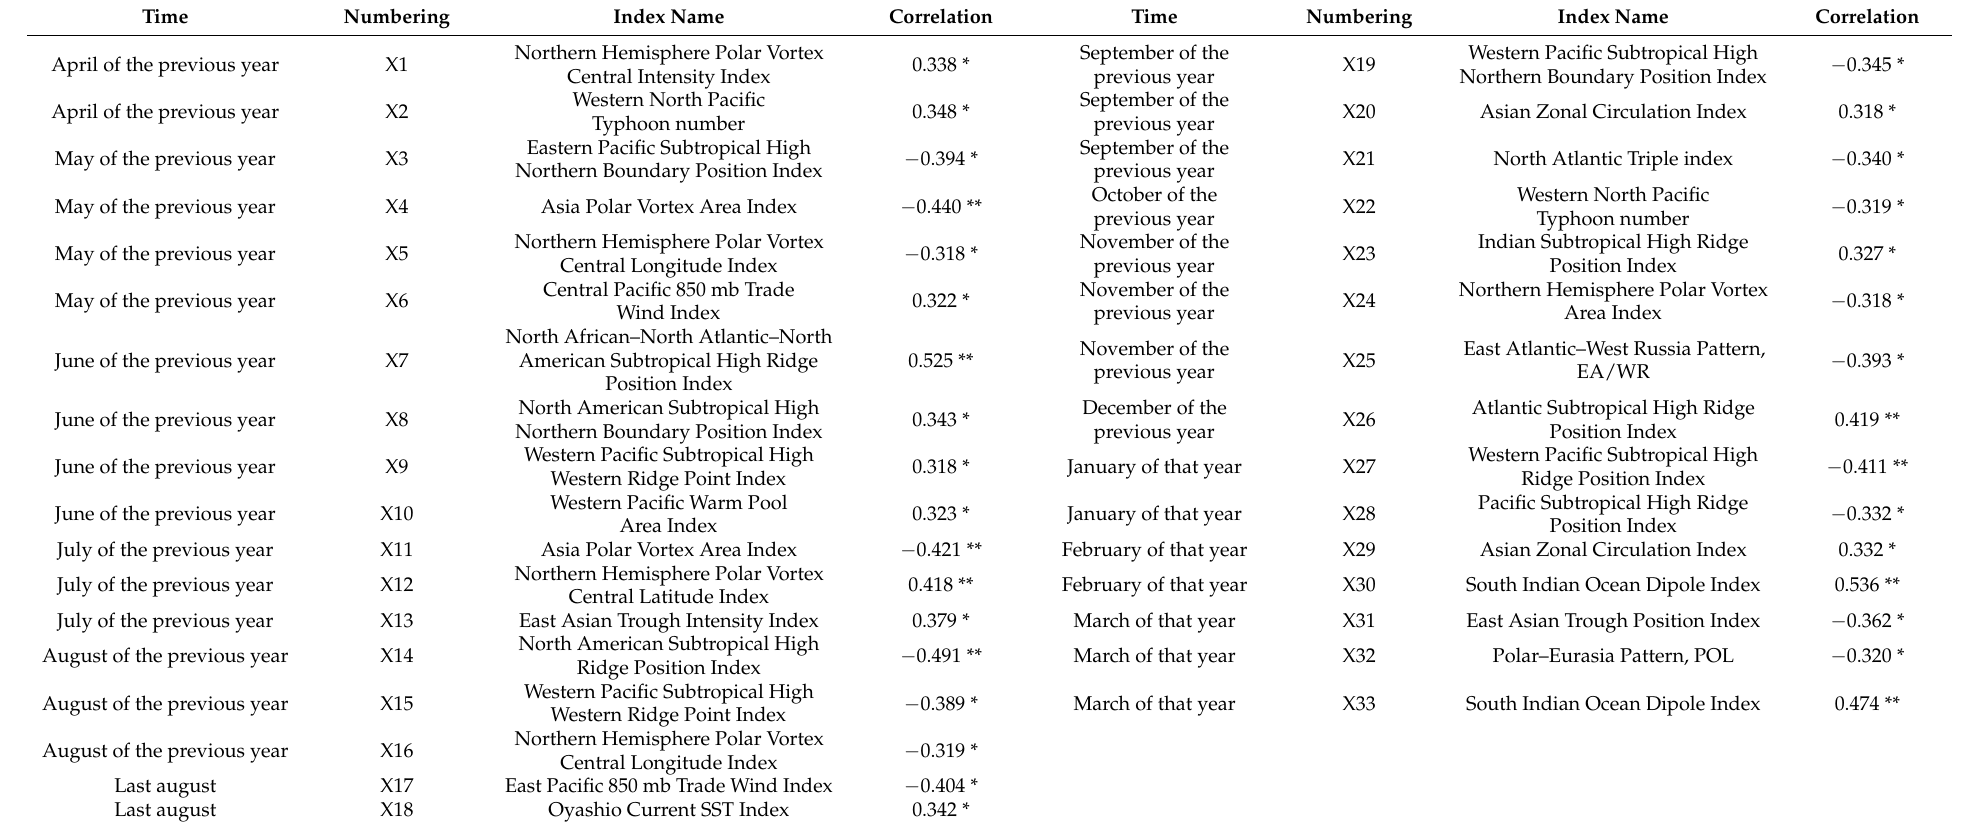
Table 1. Correlation analysis was carried out for potential evaporation in the growing season (April–October) with a time lag of 12 months (April–December of the previous year and January–March of the current year), and a significant p was selected. Atmospheric circulation factor <